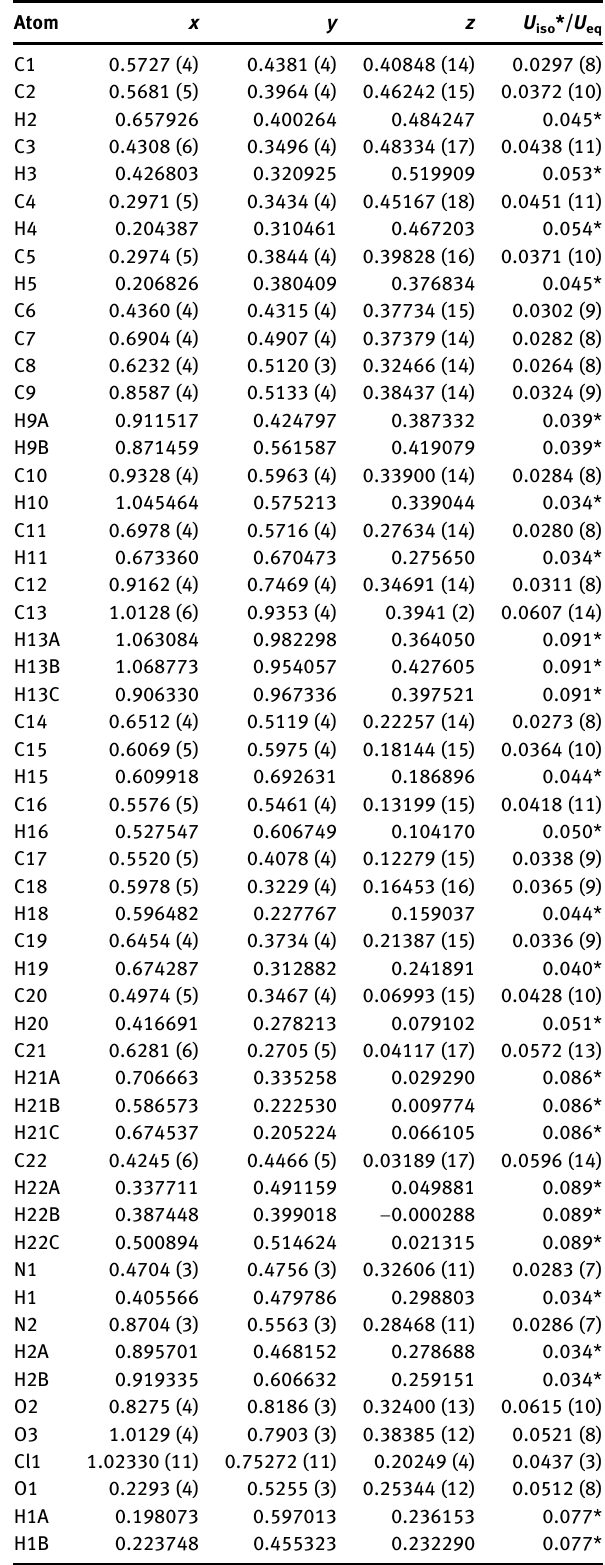
Table  : Fractional atomic coordinates and isotropic or equivalent isotropic displacement parameters (Å 